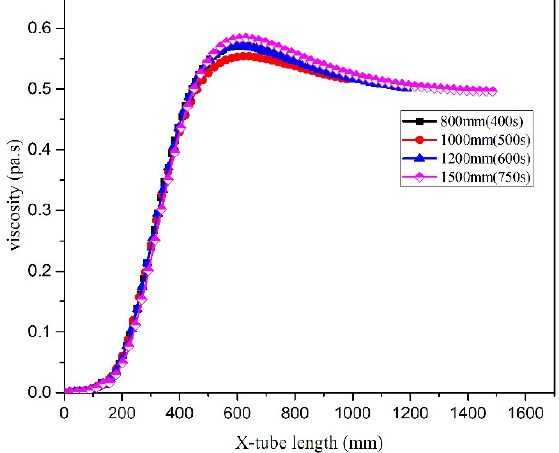
Figure 25. Viscosity curve in microreactor at different residence times.